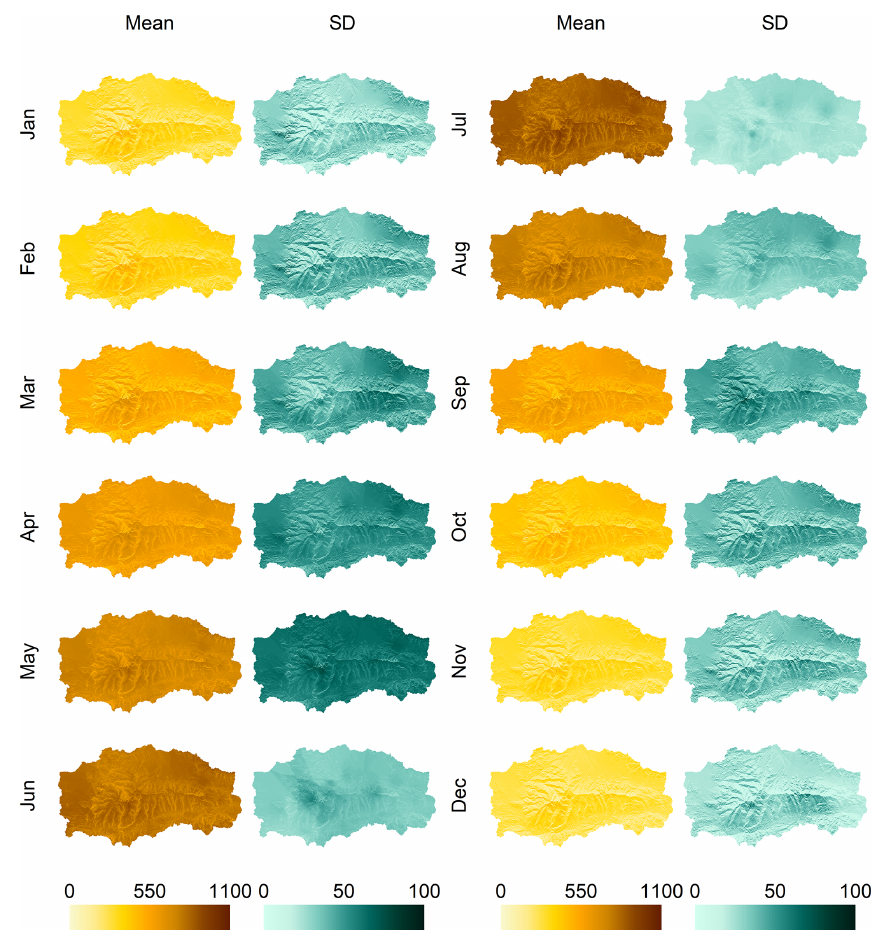
Figure 8. Monthly average and standard deviation of R g (MJm − 2 per month) in the study period (2000–2018) in